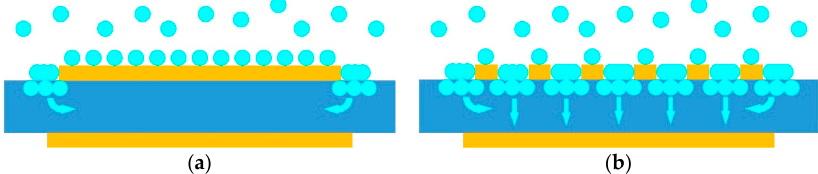
Figure 2. Schematic diagrams of adsorption on surface of the FBAR sensors: ( a ) model with complete electrode; ( b ) model with micro through-holes in top electrode.